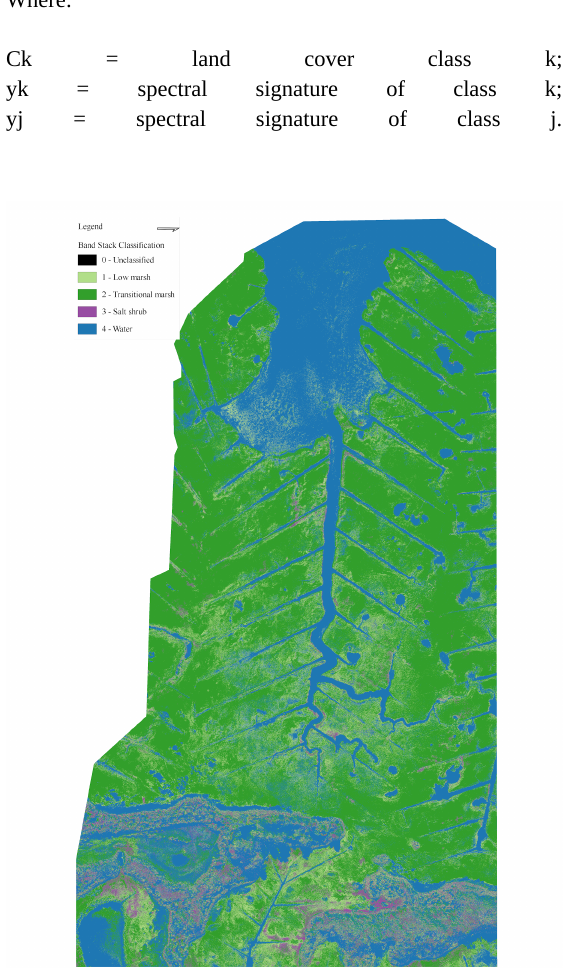
Figure 8. Stacked Band Composite Classification We repeated this same process using the subset of validation points and the same water ROI training polygons on the